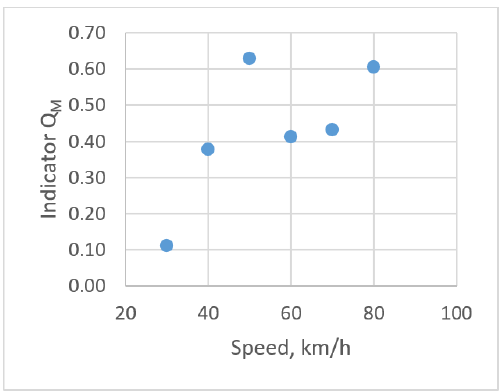
Figure 21. Values Q M considering the loaded wagon maximal vertical forces.